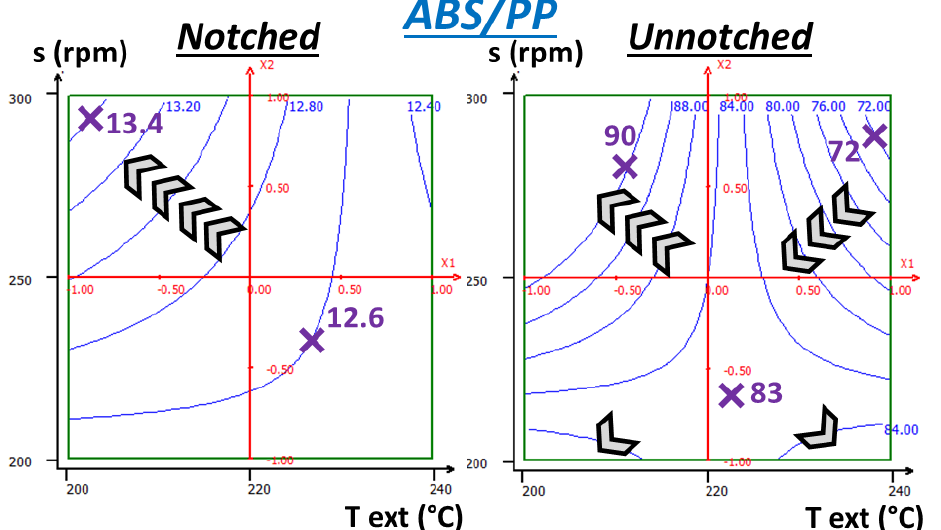
Figure 15. RSM applied to notched and unnotched Charpy break energies (kJ/m 2 ) of ABS + 4 wt% PP—extruder temperature (200–240 ◦ C) and screw speed (200–300 rpm) as variables—chevrons indicate increasing energy